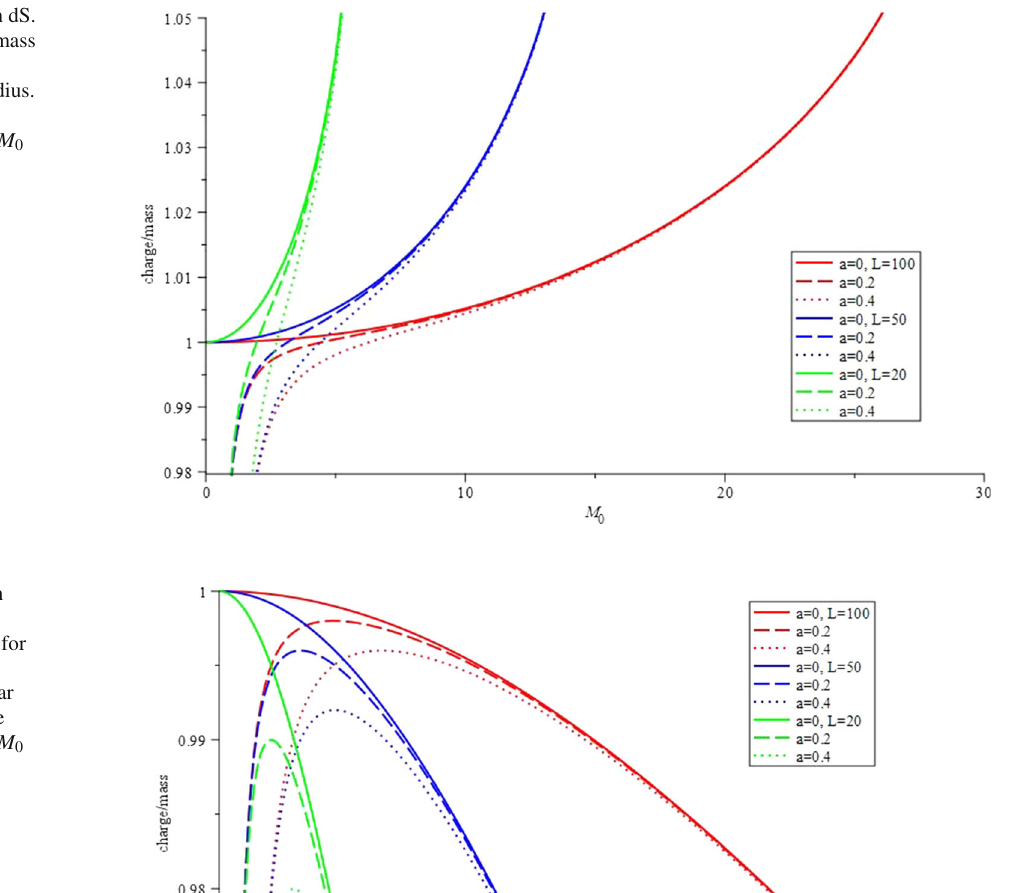
Fig. 3 Charge-mass ratio in dS. For a given M 0 , the charge-mass ratio is larger for a small dS radius than for a large dS radius. The rotation a lowers the charge-mass ratio for given M 0 and L